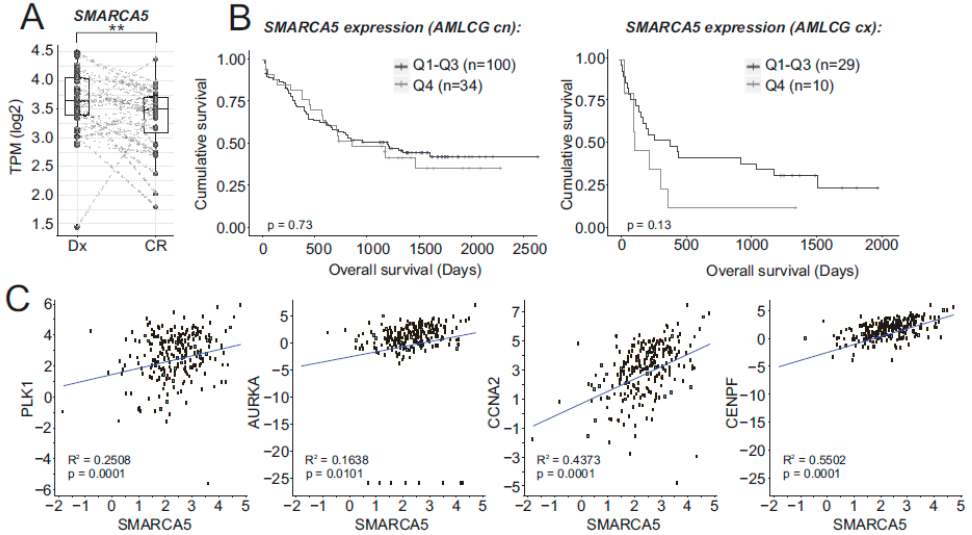
Figure 1. ( A ) SMARCA5 expression of matched AML samples at the time of diagnosis (Dx) and complete remission (CR). Dots represent individual samples; dashed lines connect matched patient samples. Boxes: distribution of the Dx and CR groups; intermediate line = median. Significance was estimated using a paired Wilcoxon test. ( B ) Survival analysis of AML patients divided into quartiles (from low Q1 to high Q4; Q1: 0%–25% + Q2: 25%–50% + Q3: 50%–75% vs. Q4: 75%–100%) based on SMARCA5 mRNA levels (cn: cytogenetically normal, cx: cytogenetic abnormalities). ( C ) Correlation of mRNA levels of PLK1, AURKA, CCNA2, CENPF, and SMARCA5 (R 2 and p-value indicated) .